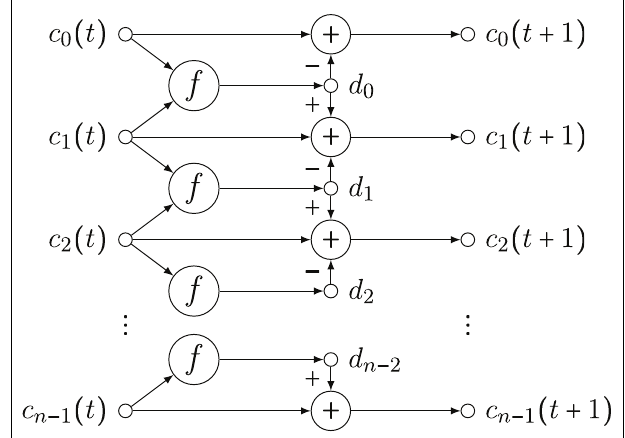
FIGURE 6 | Diagram of the proposed recurrent network . f is the function to compute the